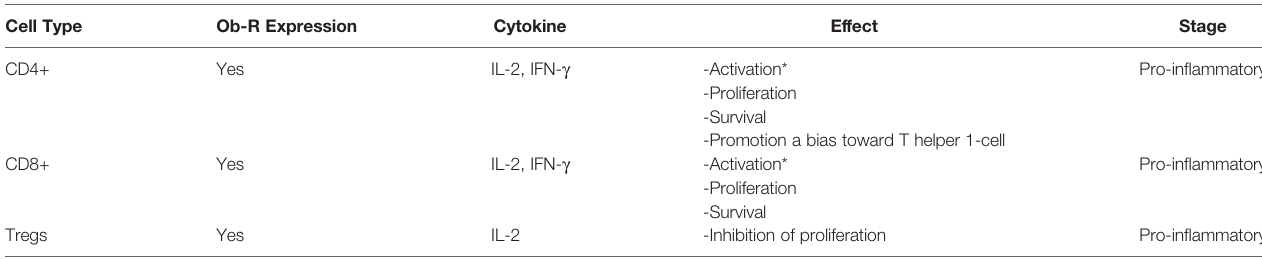
TABLE 1 | Potential effects of leptin in adaptive immune